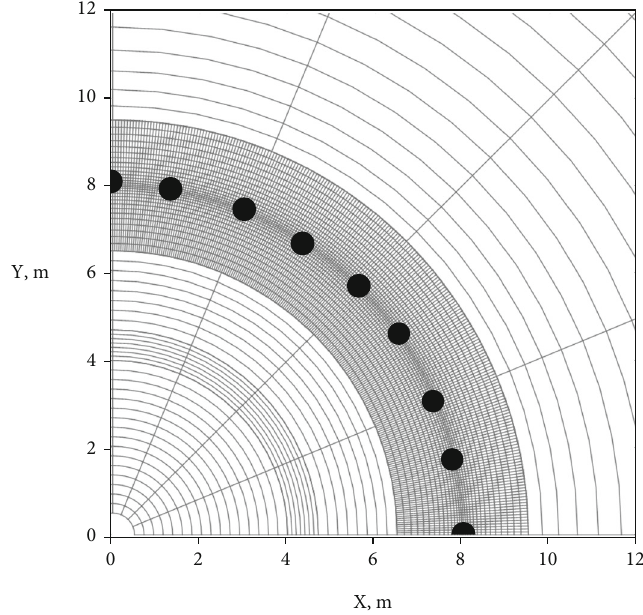
Figure 2: Part of the computational domain divided into concentric rings.